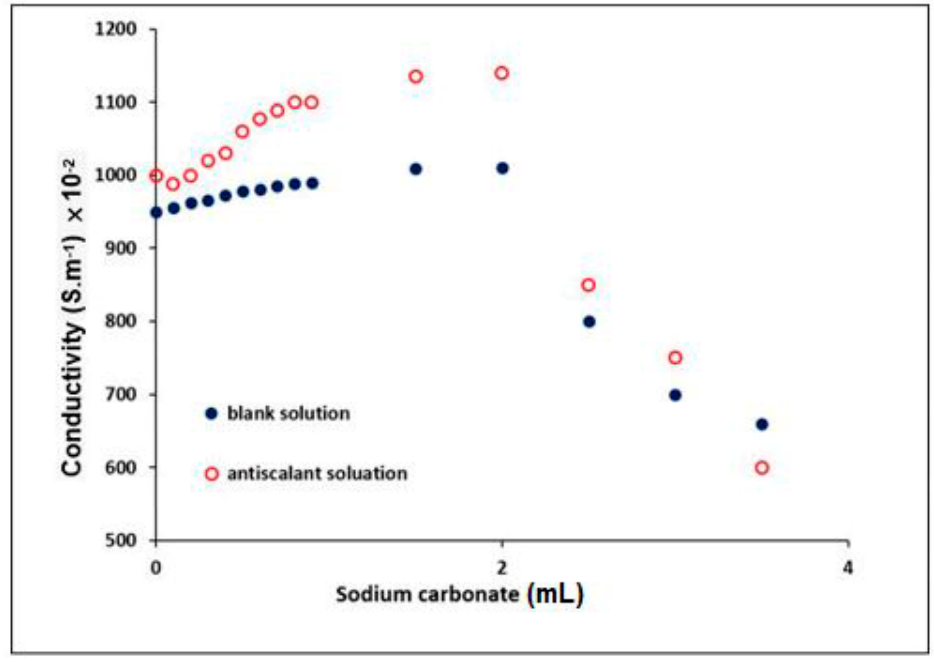
Figure 9. Variation in the conductivity in the presence and absence of 10 mg·L − 1 CA-co-GLC at 25 °C and pH 9.